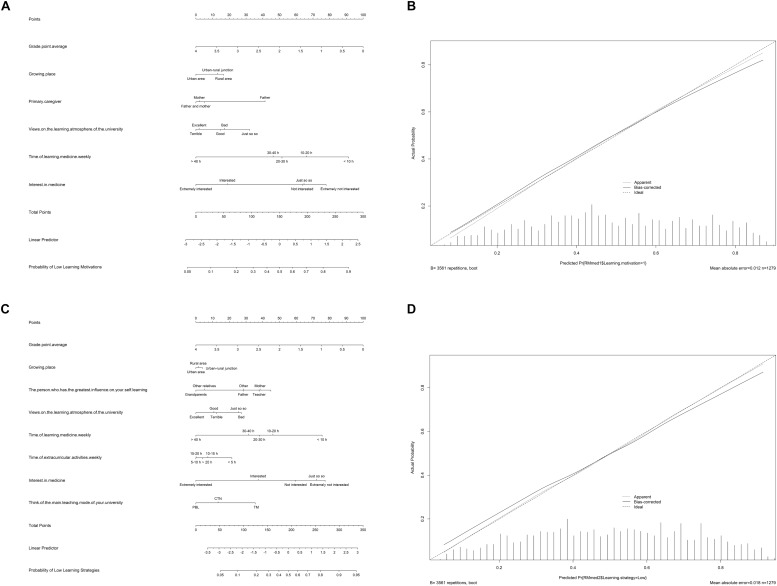
Nomograms and calibration curves of predicting learning motivation level (A,B) and learning strategy level (C,D). Based on the final multivariable Logistic regression models, the nomograms predicting learning motivation [area under curve (AUC): 0.733; internal validation C-index, 0.736] and learning strategy level (AUC: 0.749; Internal validation C-index, 0.744) were established, which were defined as the final models predicting SRL levels in Chinese undergraduate medical students. The prediction models could predict SRL levels of the other undergraduate medical students outside the study cohort. For instance, for a senior who just entered the hospital as an intern, the teachers could investigate the variables information in the nomograms of this intern and calculate the possibility of low SRL levels. According to the predicting results, teachers could quantitatively identify students with low SRL levels and conduct personalized intervention. PBL, problem-based learning; TM, traditional teaching mode; CTN, combination of traditional teaching and non-traditional teaching.